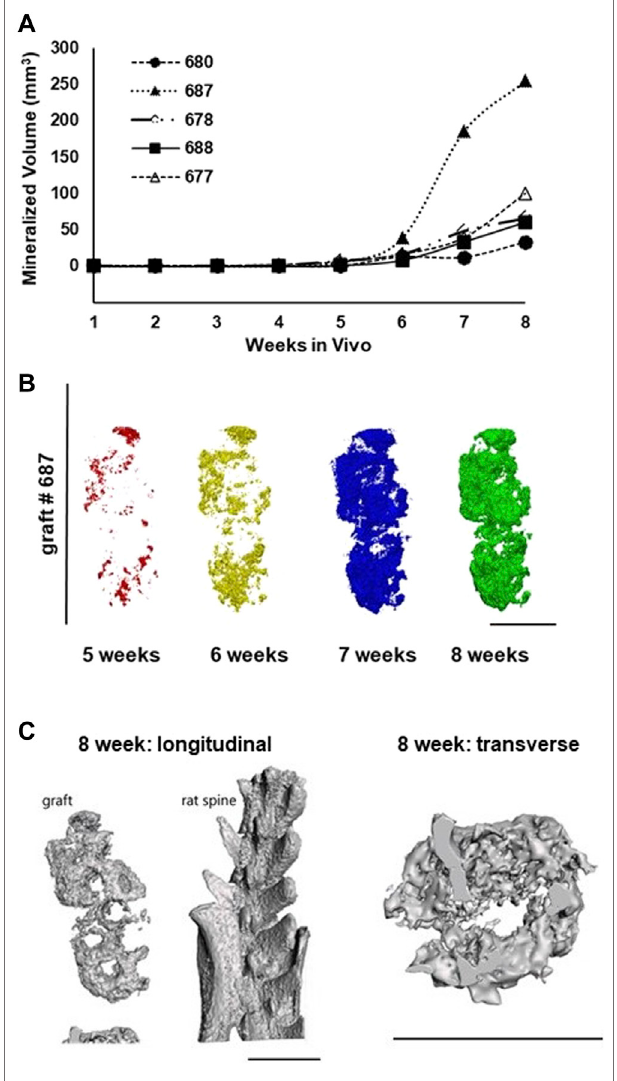
FIGURE 5 | Implanted grafts progressively mineralize over the 8-week period as assessed by microCT imaging. (A) Time course of graft ossi fi cation for the 5 grafts implanted for 8 weeks. (B) Projections of rendered microCT scans for graft 687 from week 5 through week 8 showing the spatial progression of ossi fi cation within the graft. (C) 3D renderings of graft #687 implant thresholded to show bone-equivalent density and internal structure. Scale bars in all panels equal 1